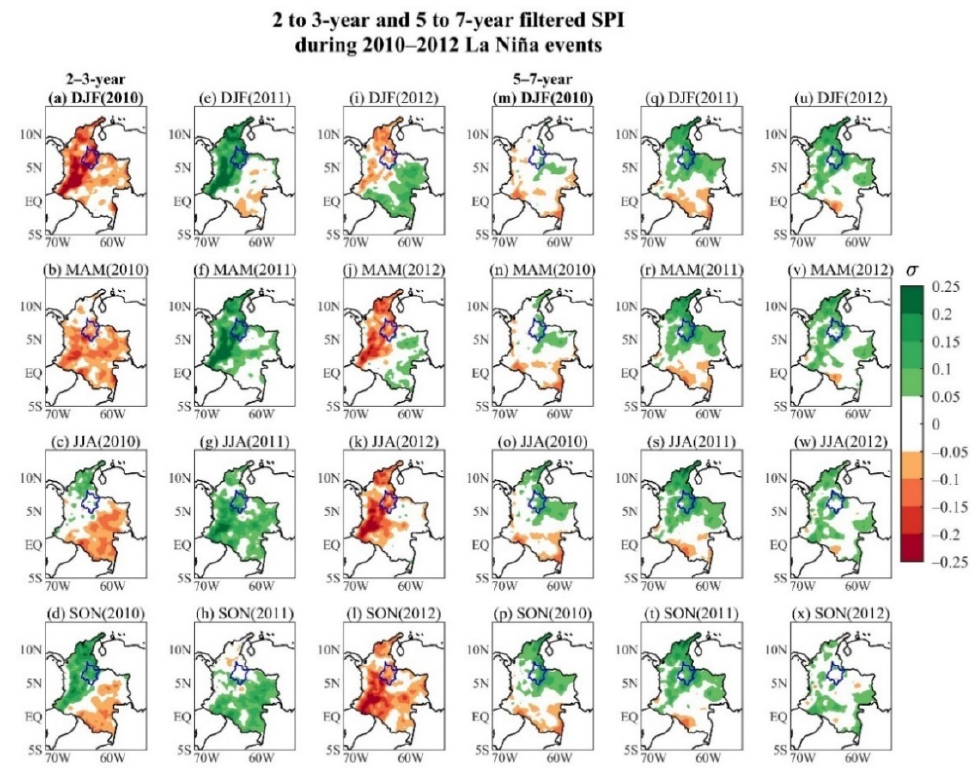
Figure 11. Seasonal standardized precipitation index (SPI) filtered at ( a – l ) biannual 2–3-year and ( m – x ) interannual 5–7-year scales between DJF 2010 and SON 2012.